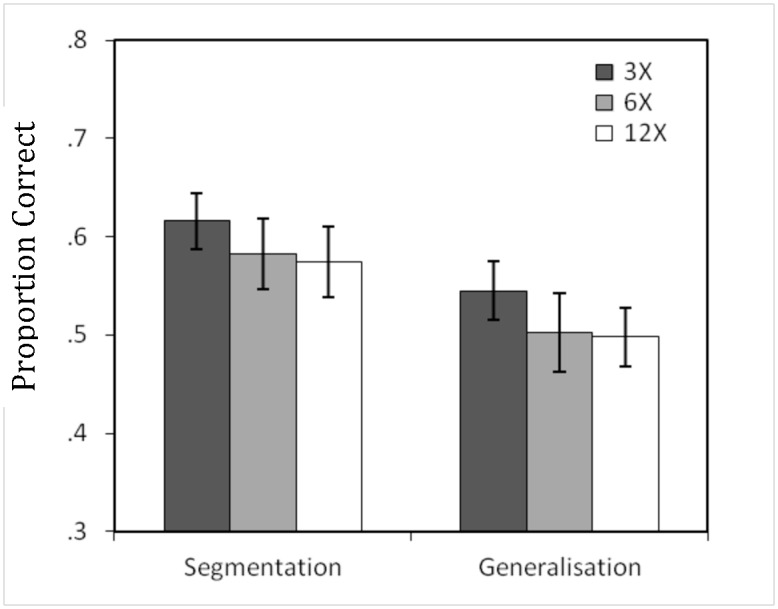
Mean proportion of correct responses on the segmentation and generalisation tasks after familiarisation for each set-size of intermediate syllables (raw accuracy scores).Error bars show standard errors.